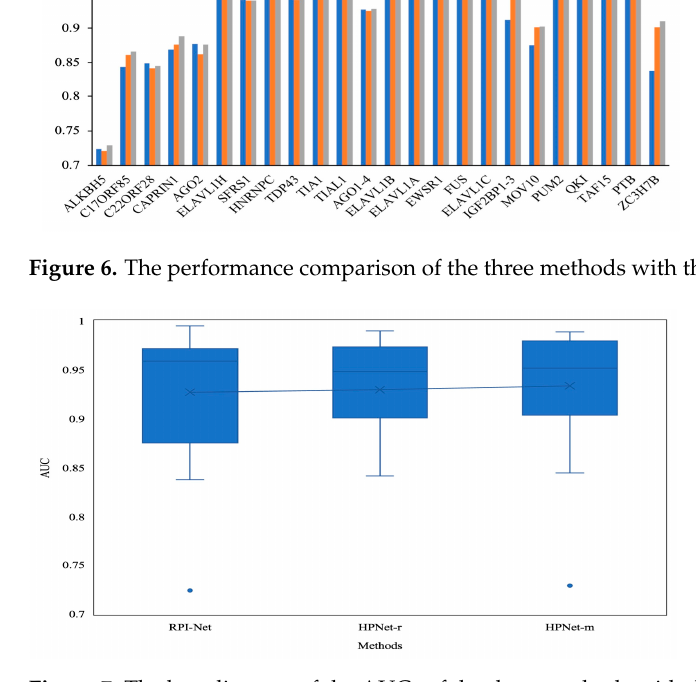
Figure 7. The box diagram of the AUCs of the three methods with the unbiased dataset.